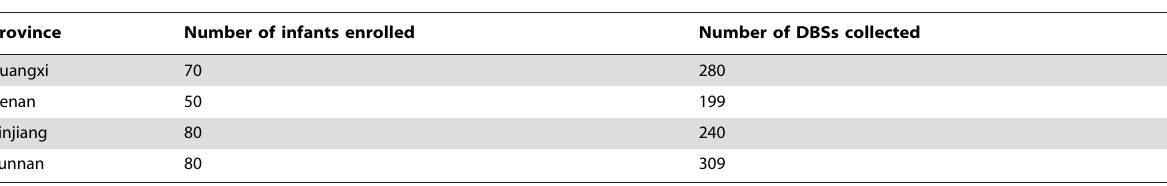
Table 1. Geographic distribution of infant DBSs collected.